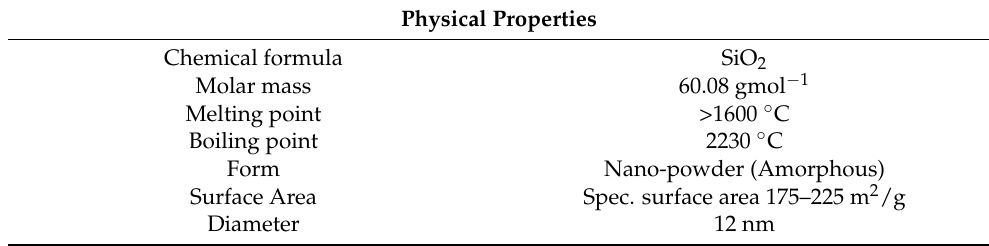
Table 1. Physical properties of quartz nano-particles